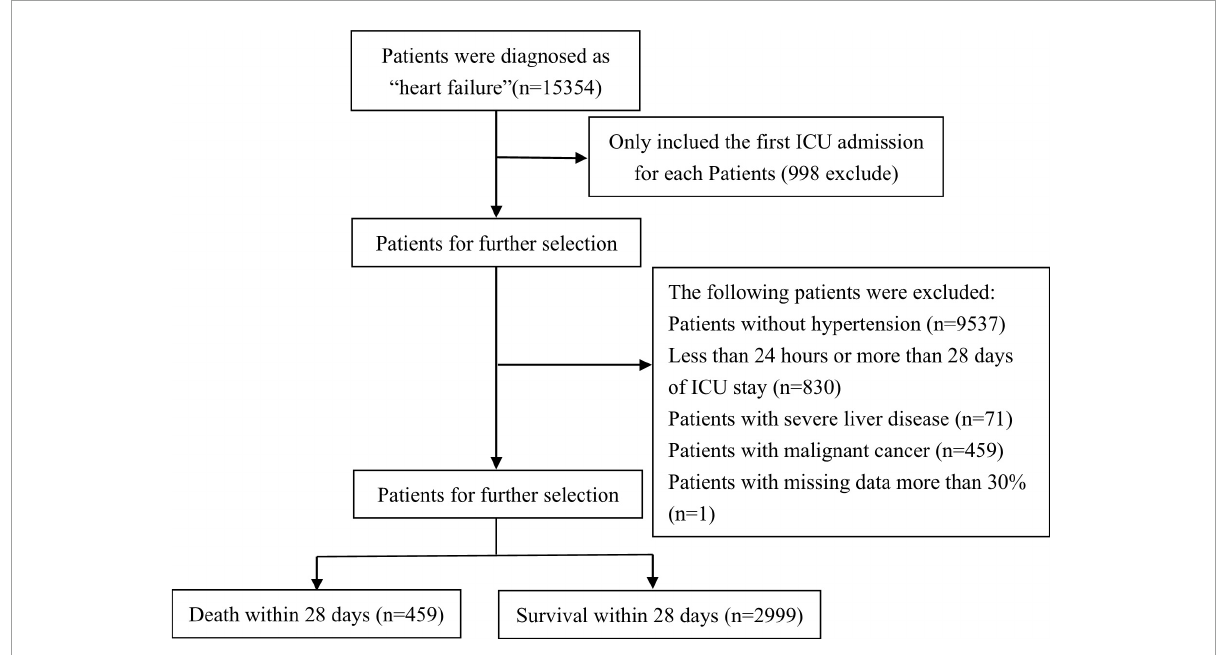
FIGURE1 A flow chart describing the procedure for subject